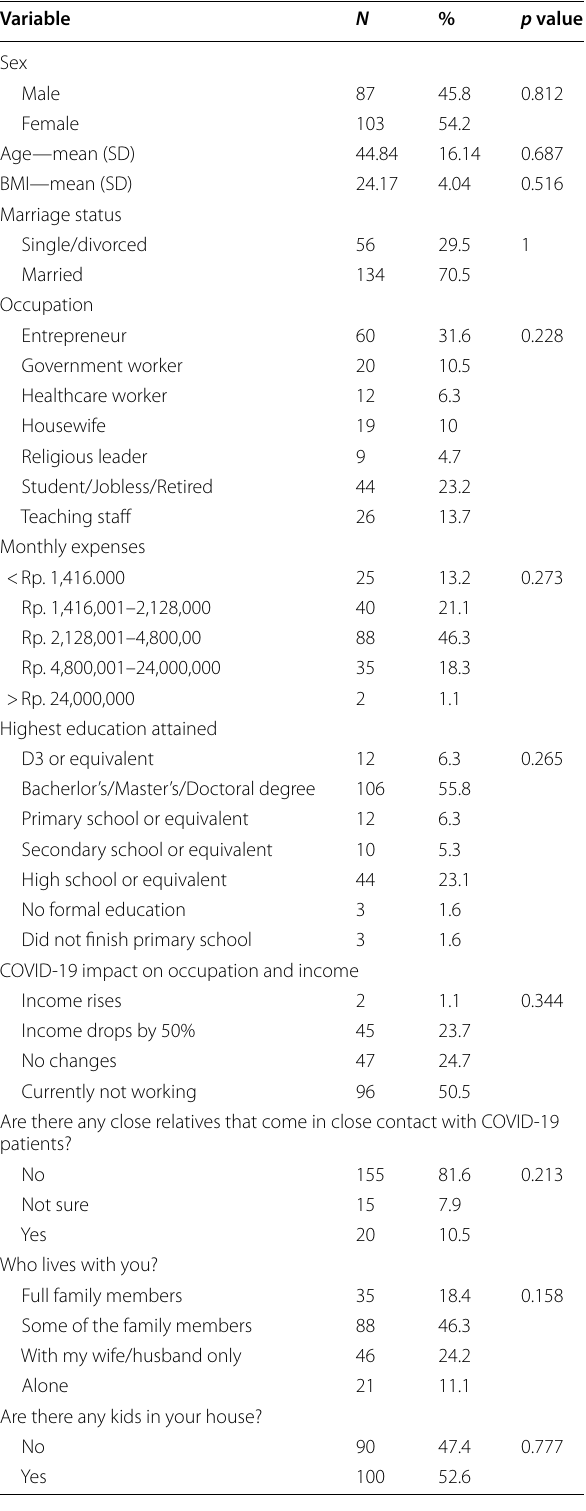
Table 1 Demographic characteristics of the